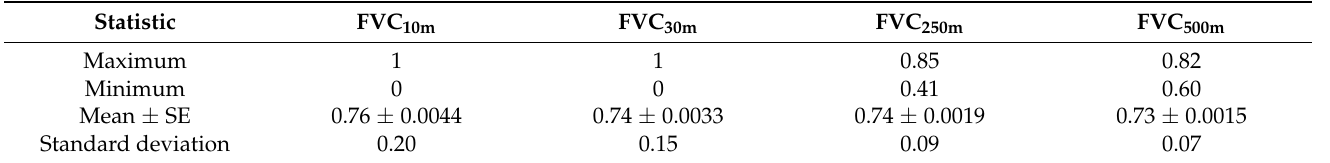
ervoir and Daxi Reservoir in Tianmuhu township (see Figure 1b for location). Table 3. Statistics of FVCs extracted from images of different spatial resolution from the sample site shown in Figure 2.